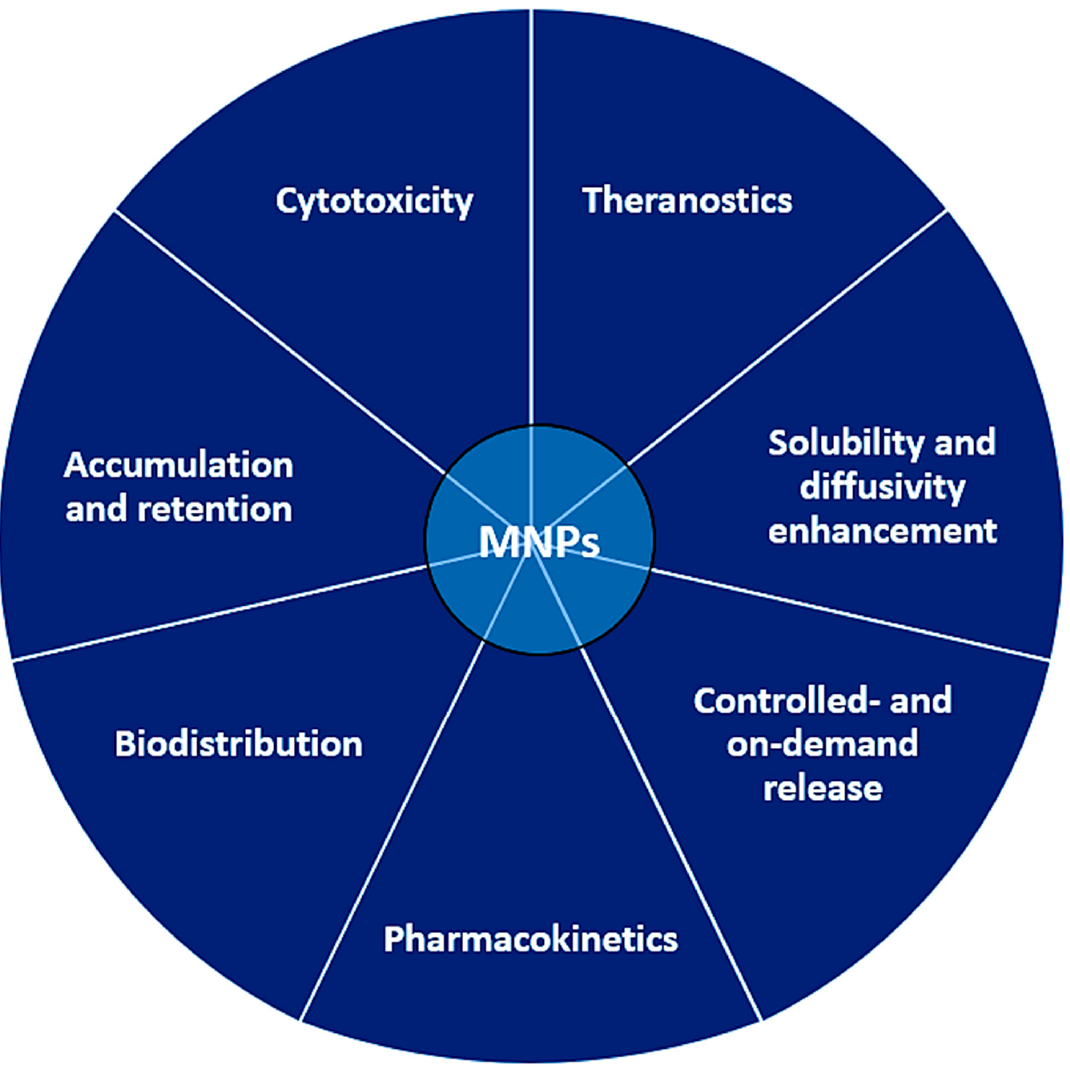
Figure 1. Advantages of using NP-based carrier platforms compared to classical drug administration protocols; improvements are recorded across all presented segments.